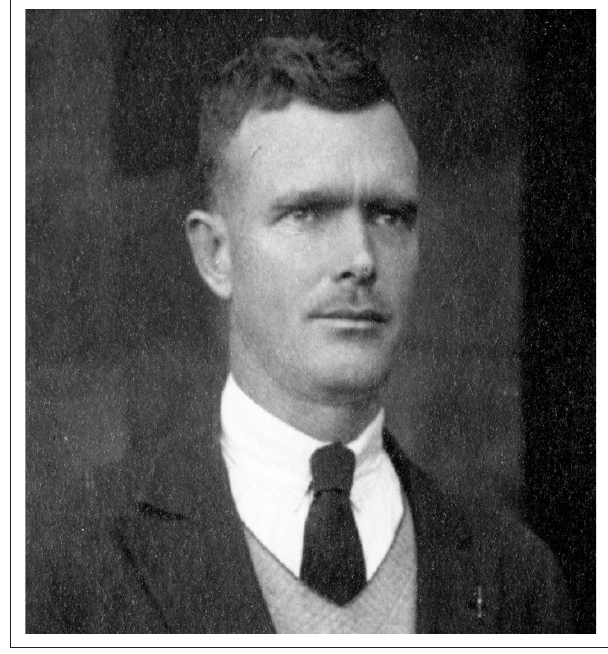
Source : Photograph courtesy of Dr D. Verwoerd from the University of Pretoria FIGURE 4: Dr H.H. Curson (circa